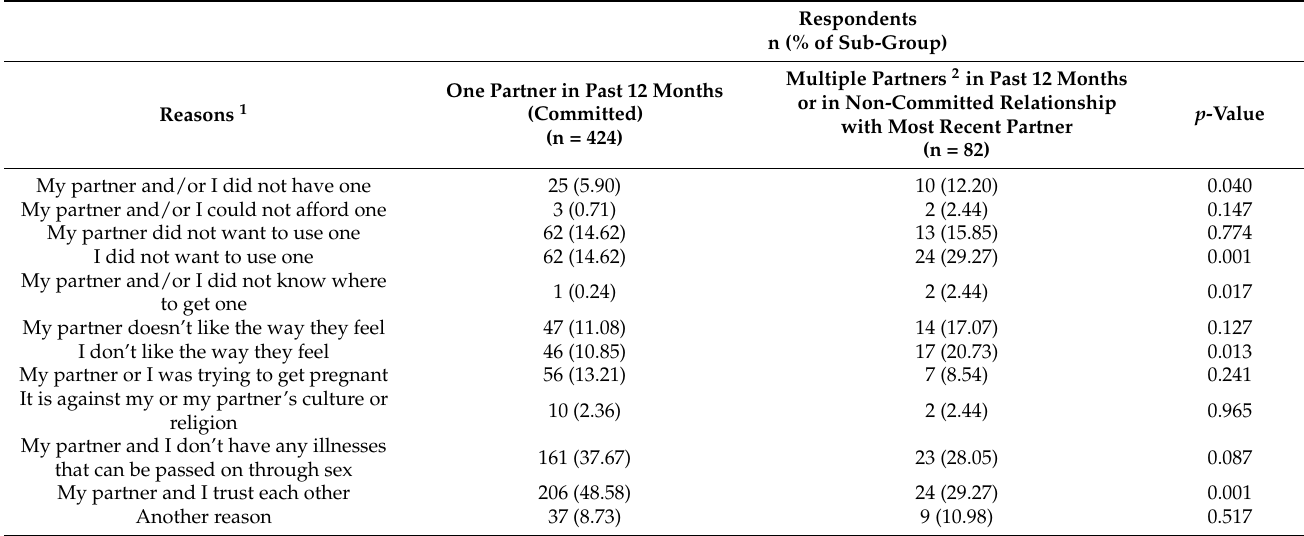
Table 5. Responses to reason for condom non-use (Why did you NOT use a condom the MOST RECENT time you had sex?), by number and type of partners (n = 506).